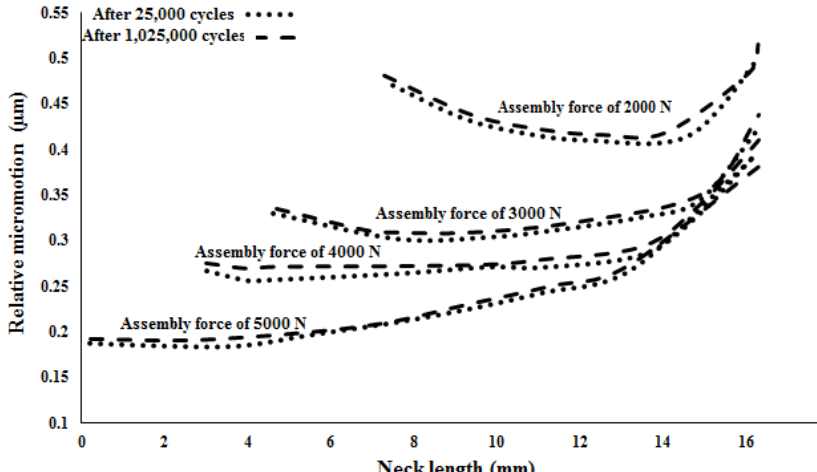
Figure 5. Relative micro-motion at the contacting interface over the neck length (super-lateral sector) for different assembly forces after 25,000 and 1,025,000 cycles.